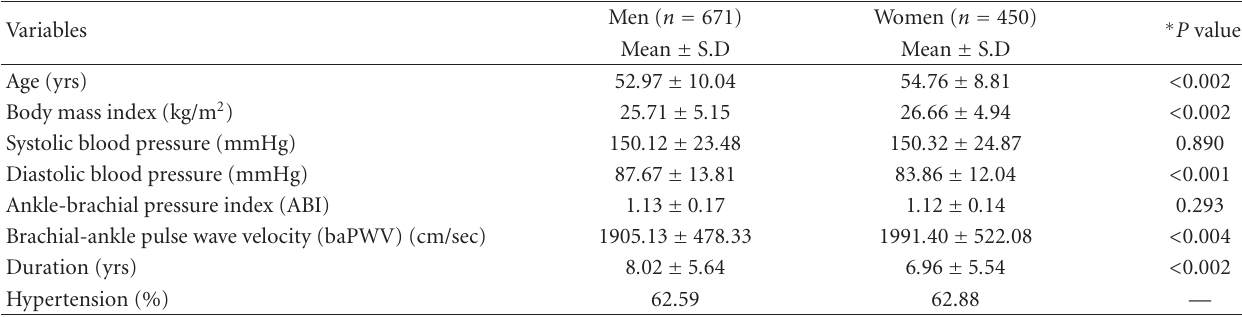
Table 1: Clinical characteristics of the subjects with type 2 diabetes